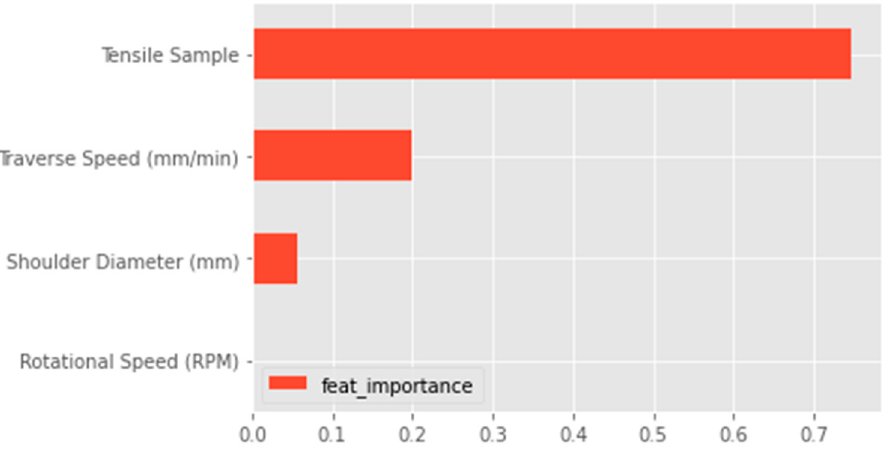
Figure 5. Feature importance plot.